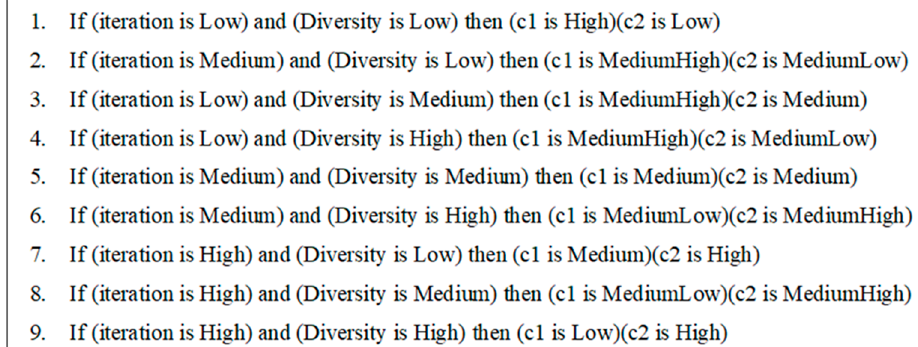
Figure 4. Fuzzy rules proposed for the first fuzzy system.